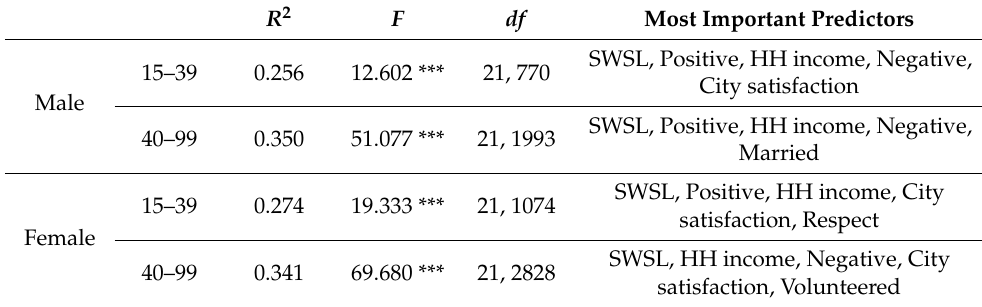
Table 4. Regression Results across Age and Gender Groups.